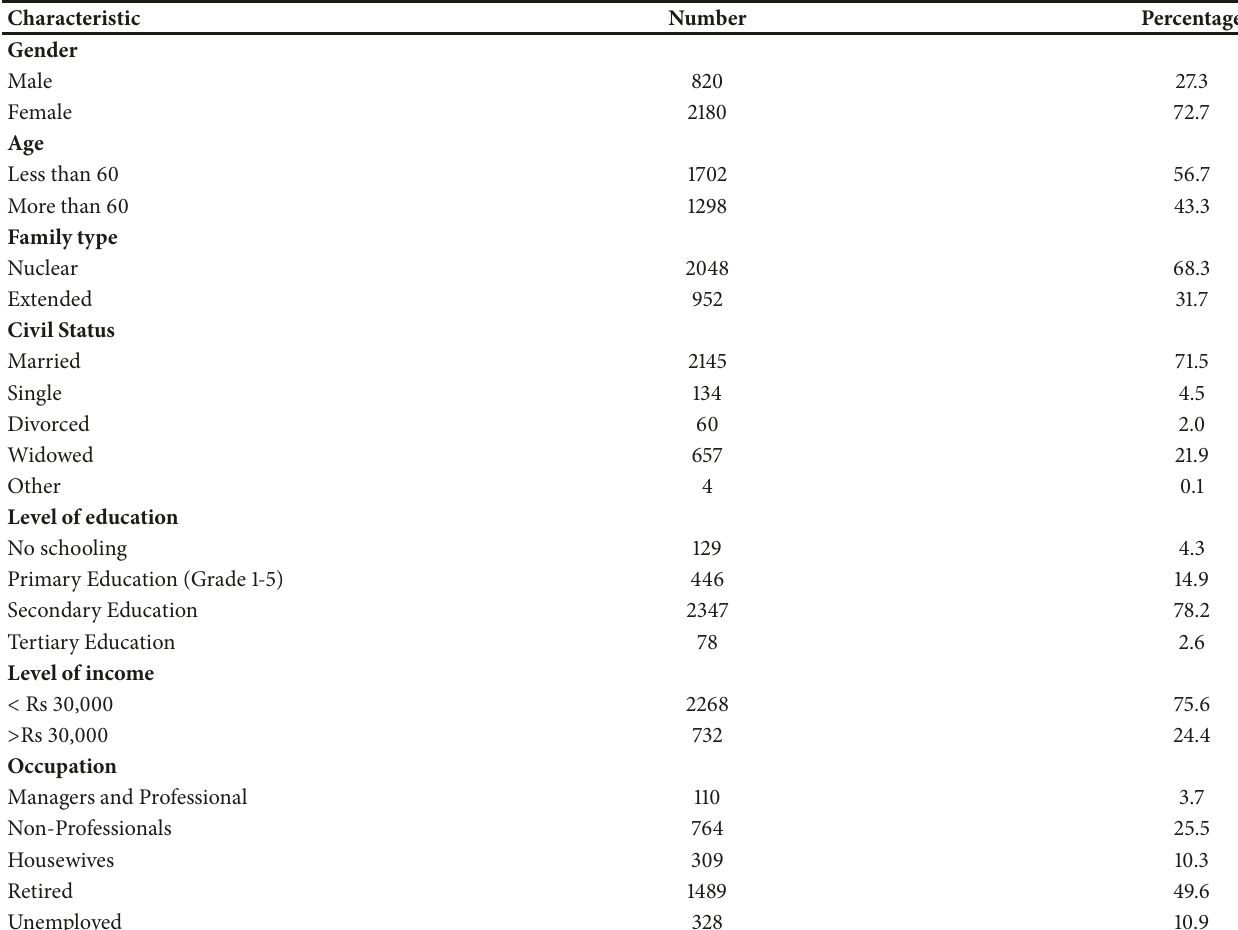
Table 1: Sociodemographic characteristics of the